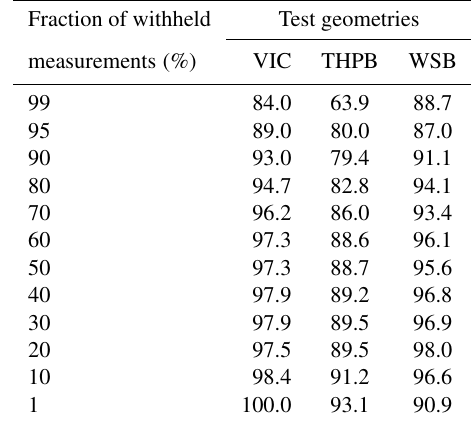
Table 1. Fraction of all validation measurements for which the ab- solute mismatch is less than the predicted error estimate. Values are given in